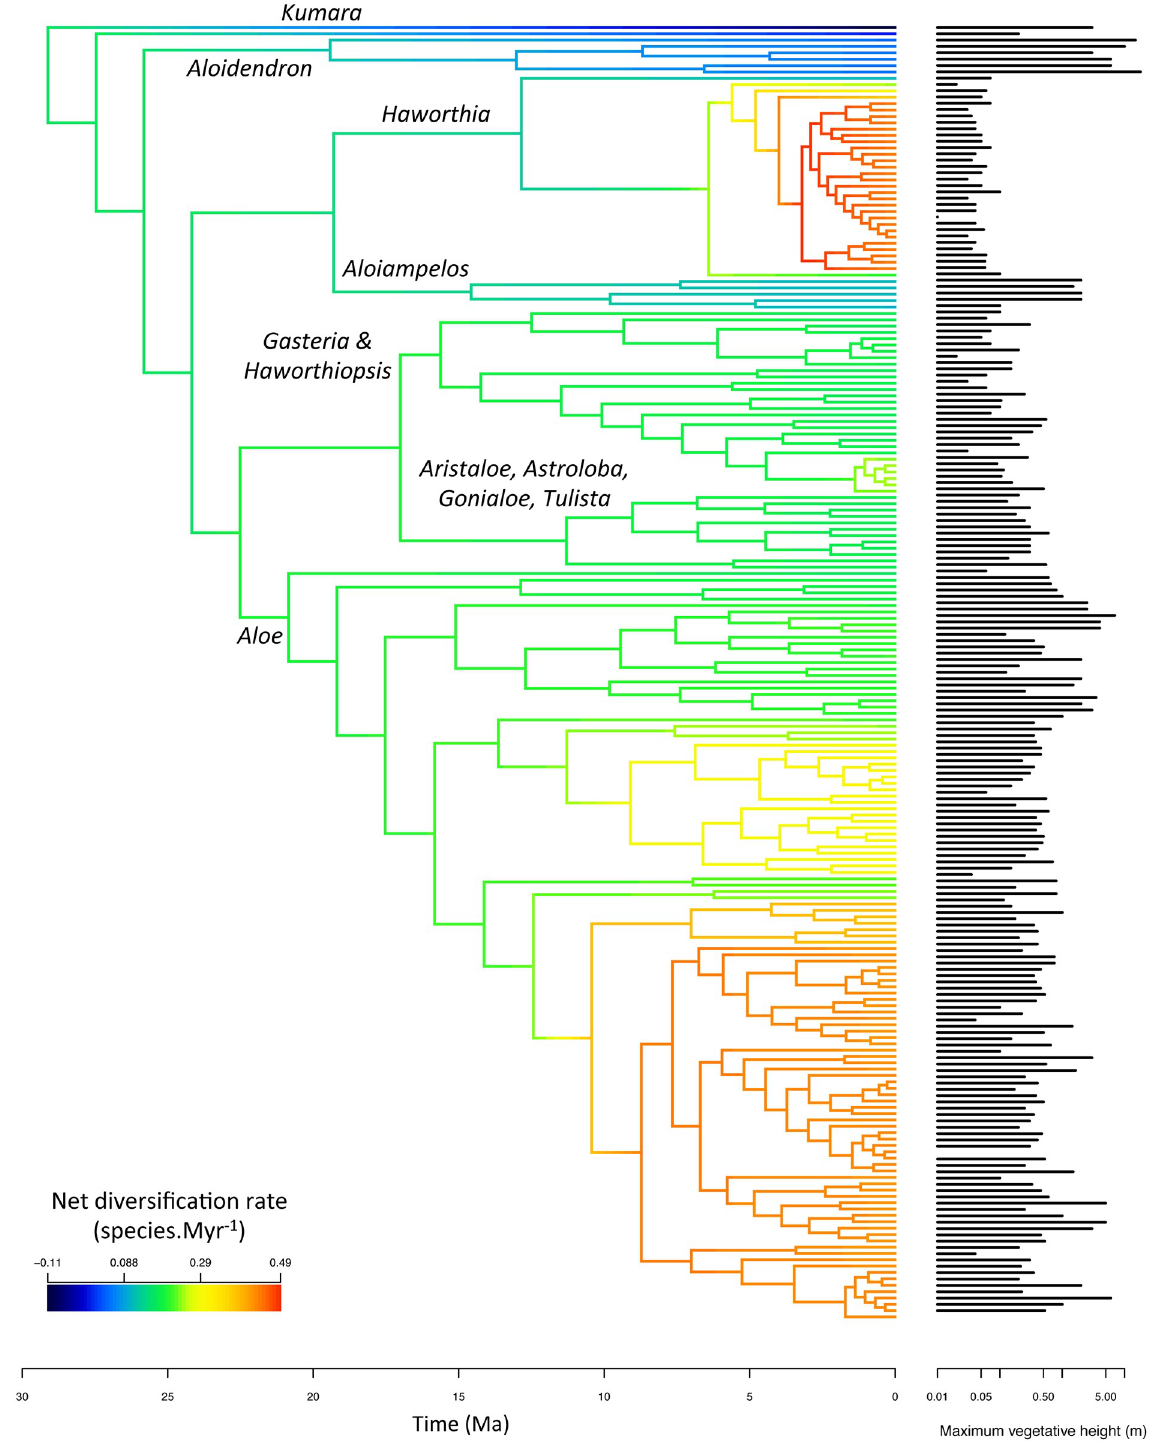
Fig 2. Phylogeny, diversification and height in Alooideae. The figure shows the maximum clade credibility tree of Alooideae. In order to illustrate the heterogeneity of diversification rates within Alooideae, branches in the tree have been colored according to their instantaneous net diversification rate, inferred using the BAMM software (Rabosky et al. 2013) under default settings and summarized across the posterior of the analysis. Bars on the right side of the phylogeny show the maximum vegetative height of each species, plotted on a log 10 -scale.